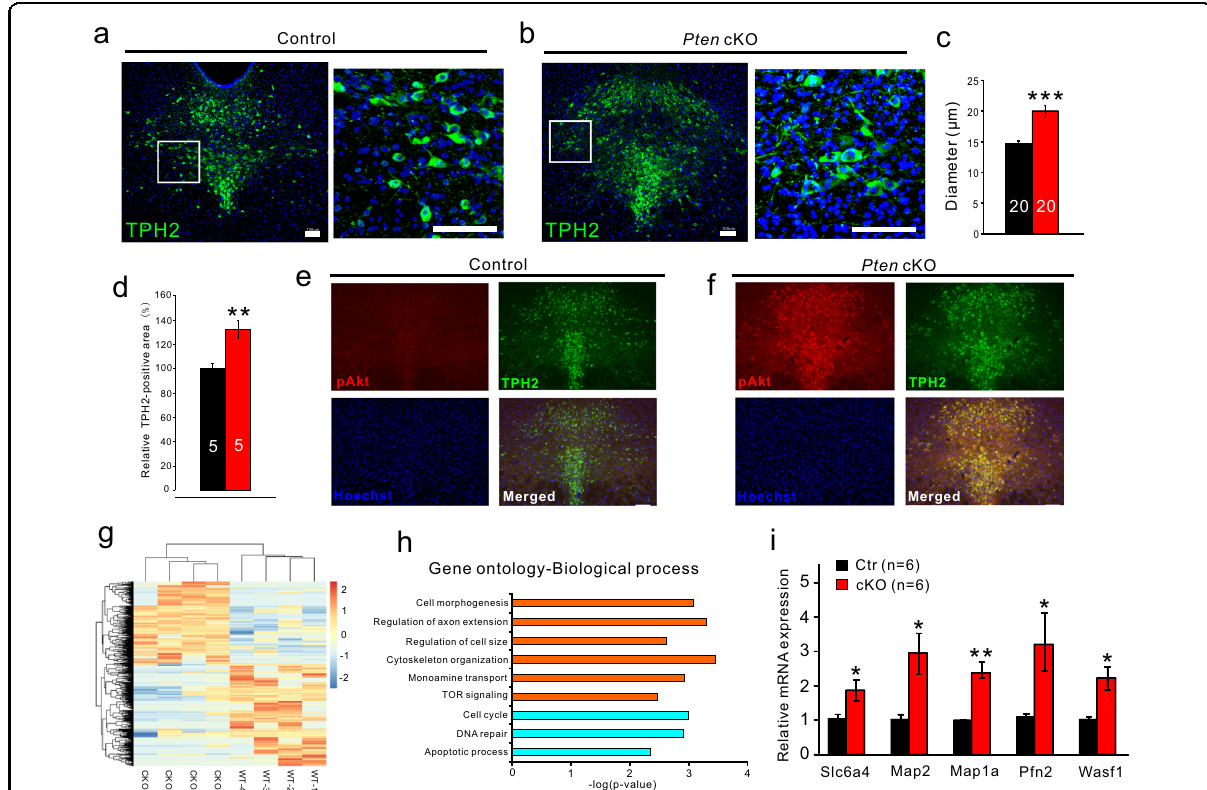
Fig. 2 Increased soma size and upregulation of the genes involved in regulating cell size and axonal extension in Pten -de fi cient 5-HT neurons. a, b TPH2 immunostaining shows the distribution of 5-HT neurons in the dorsal raphe nucleus of control and Pten cKO mice. Scale bars = 100 μ m. c Soma diameter of TPH2 + neurons ( N = 4 animals, n = 20 neurons for statistics analysis) is increased in Pten cKO mice compared with controls. d Areas containing TPH2 fl uorescence are increased in Pten cKO mice compared with controls. e, f Double immunostaining of TPH2 and pAkt shows a dramatic elevation of pAkt in 5-HT neurons in the dorsal raphe nucleus of Pten cKO mice compared with controls. Scale bars = 100 μ m. g Heatmap depicting differentially expressed genes (DEGs) determined by genome-wide RNA sequencing (RNA-Seq) of control and Pten -de fi cient 5- HT neurons. Rows represent DEGs and columns represent transcriptomic pro fi les of individual 5-HT neurons. h Ingenuity Gene Ontology Analysis depicting to which biological processes the DEGs contribute (orange, upregulated in Pten -de fi cient 5-HT neurons; light blue, downregulated in Pten - de fi cient 5-HT neurons). i Upregulation of Slc6a4 , Map2 , Map1a , Pfn2 , and Wasf1 in Pten -de fi cient 5-HT neurons is con fi rmed by single-cell RT-PCR. All the data are presented as the mean ± s.e.m. * p < 0.05, ** p < 0.01, *** p < 0.001. The numbers of animals used are indicated except ( e , f